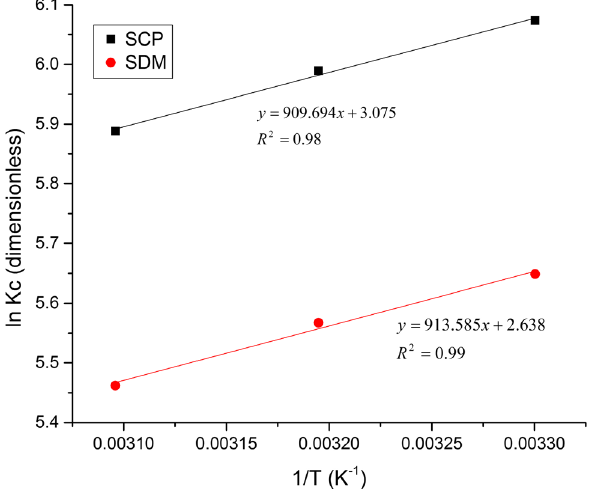
Fig. 8 van’t Hoff plots for adsorption of SCP and SDM onto Fe-MC ( m = 0.1 g/50 mL, pH =